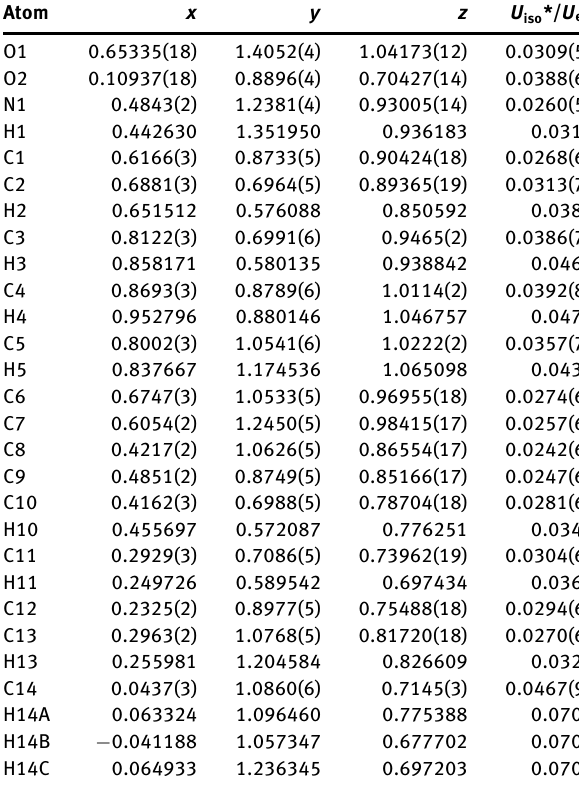
Table 2: Fractional atomic coordinates and isotropic or equivalent isotropic displacement parameters (Å 2